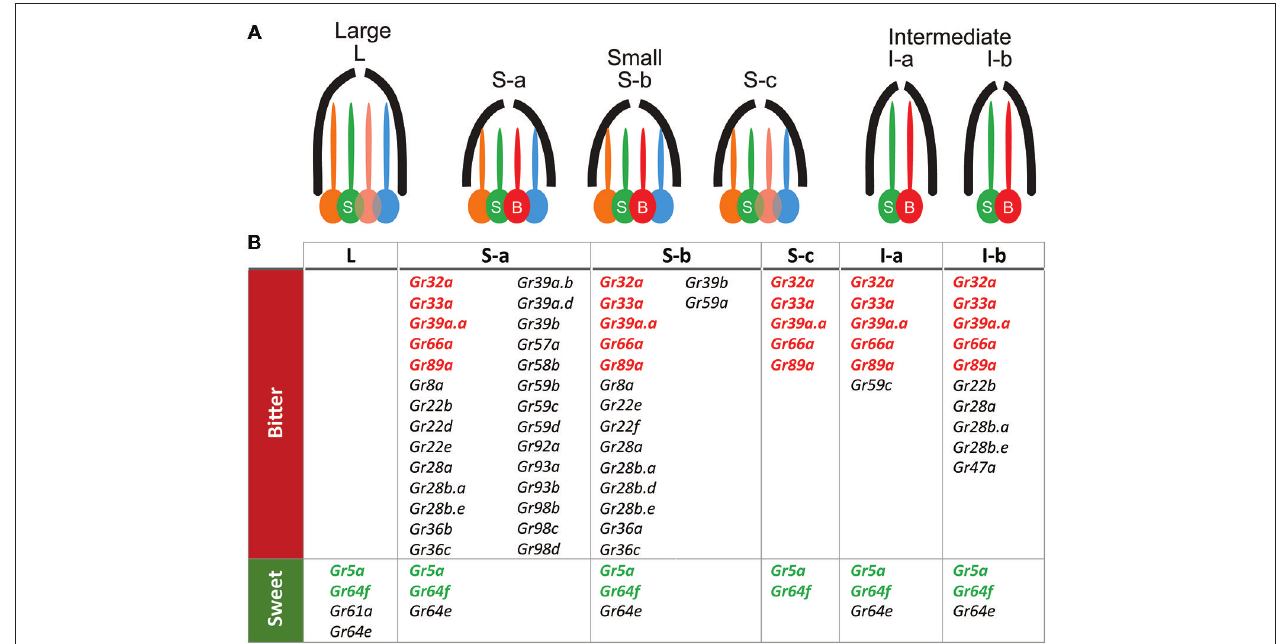
FIGURE 1 | Gr genes expressed in proboscis taste sensilla (after Weiss et al., 2011). (A) Cellular composition of the different type of sensilla located on the external side of the proboscis. L-type sensilla house four neurons, one of which is sensitive to sugars (S). S-type sensilla house four neurons, including one sugar-sensitive neuron (S) and one sensitive to bitter (B); I-type sensilla house only two taste neurons (B and S). Each of these sensilla also include one mechanoreceptor neuron not represented here. (B) Table showing a map of the expression of the gustatory genes within the different types of sensilla and bitter-sensitive (bitter row) and sugar-sensitive (sweet row) neurons. This map was obtained by establishing GAL4 lines with the promoter of each of these gustatory genes to map the neurons which express these gustatory genes.